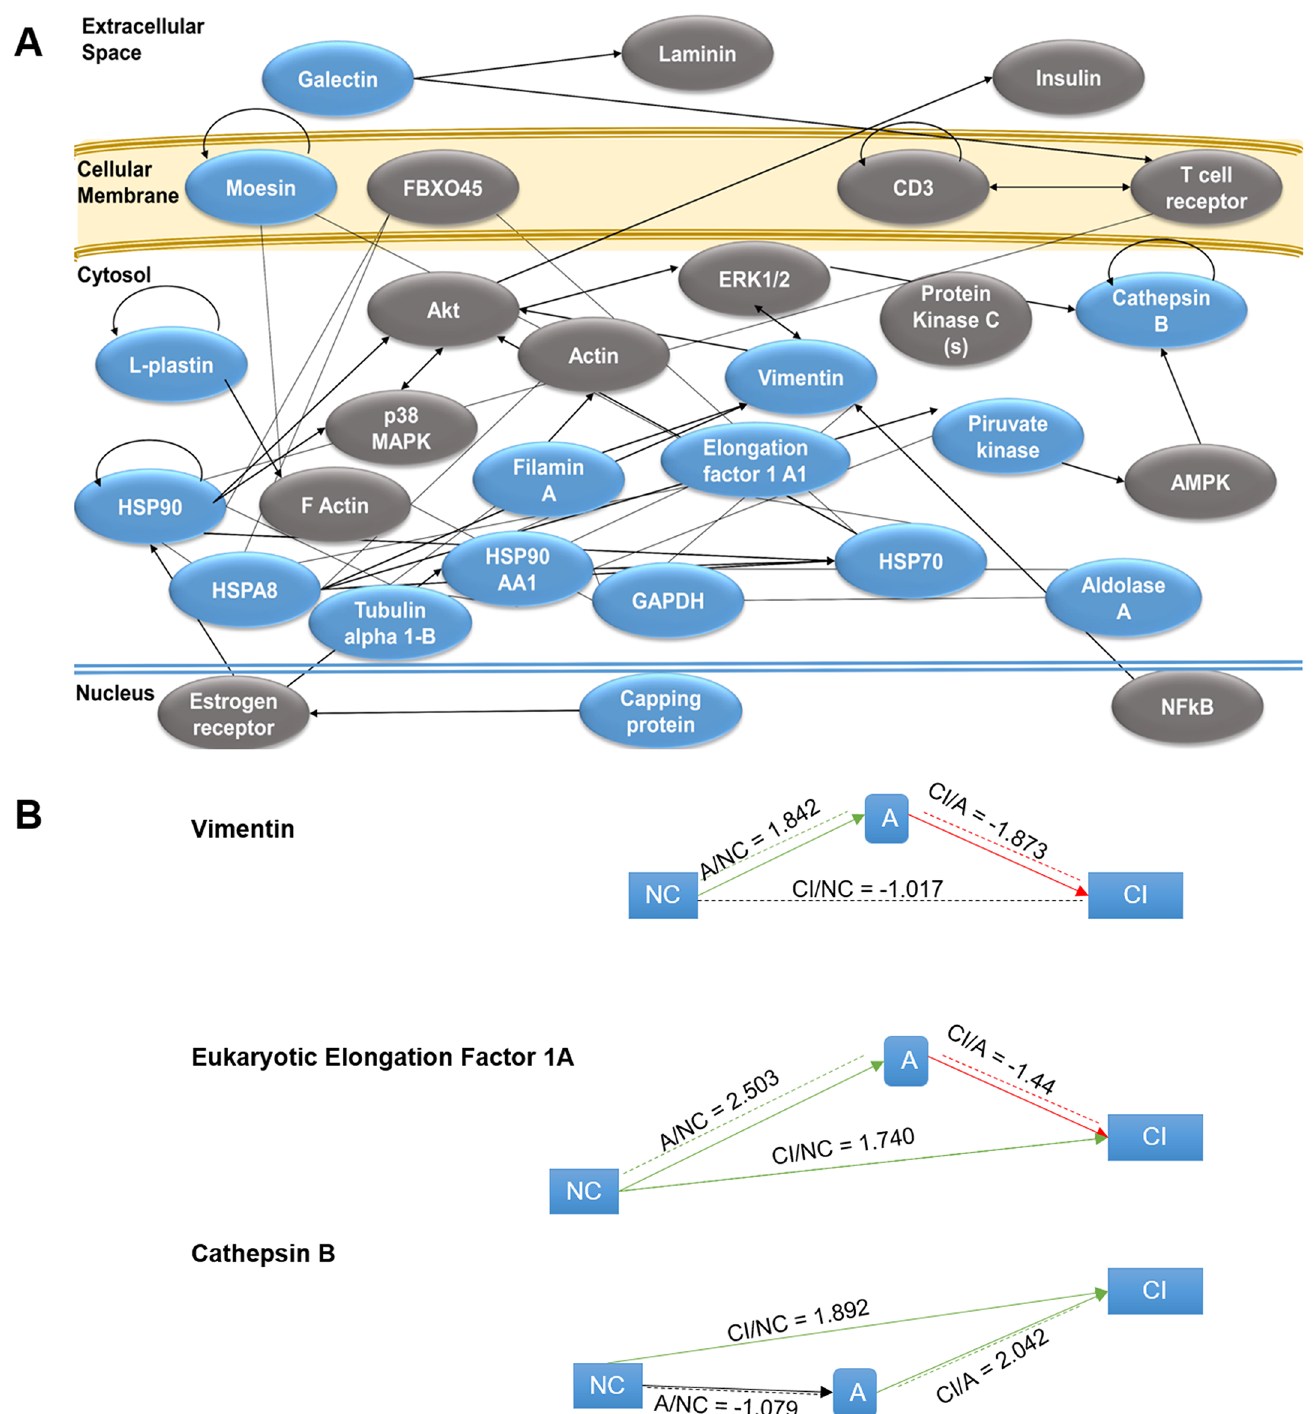
Fig 2. Predicted network of interactions between the proteins identified in macrophages from HACI patients. (A) Blue proteins are from our dataset and the grey colored proteinsare the ones that connect the proteins in our dataset accordingto IPA software. (B) The lower panel shows the pattern of increase/decreasefollowedby vimentin, EEF1 and cathepsinB amongthe groups of HACI patients.